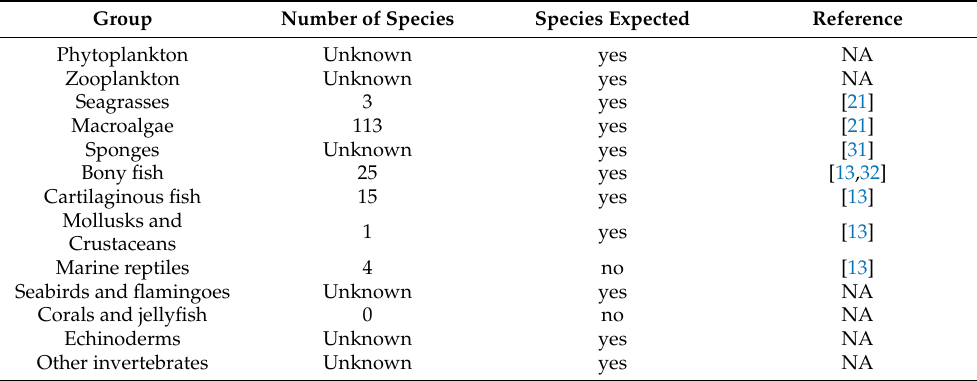
Table 2. Species diversity estimates in eastern Guajira by taxonomic